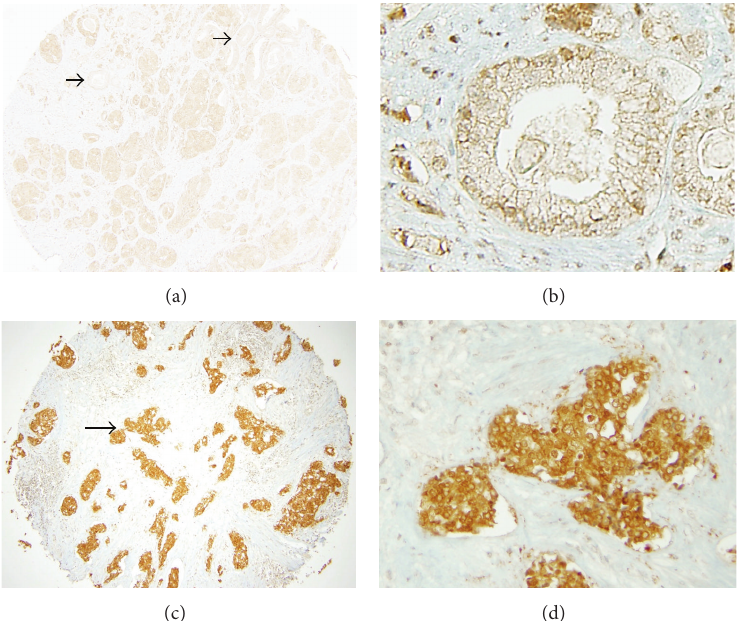
Figure 1: aPKC staining in prostatic tissue. (a and c) Representative images of aPKC staining in TMA cores of prostatic tissue. Arrows in (a) point to normal glands, and in (c) to malignant region (b) Magnified view of a normal gland showing dim (1+) aPKC staining. (d) Magnified view of malignant region showing bright (3+) aPKC staining.